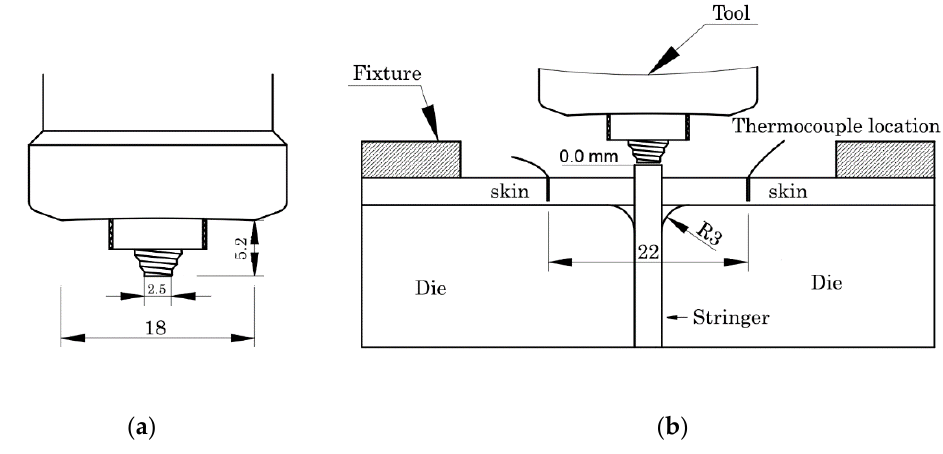
Figure 1. ( a ) Geometry of the tool; ( b ) welding setup and starting point to measure tool penetration.